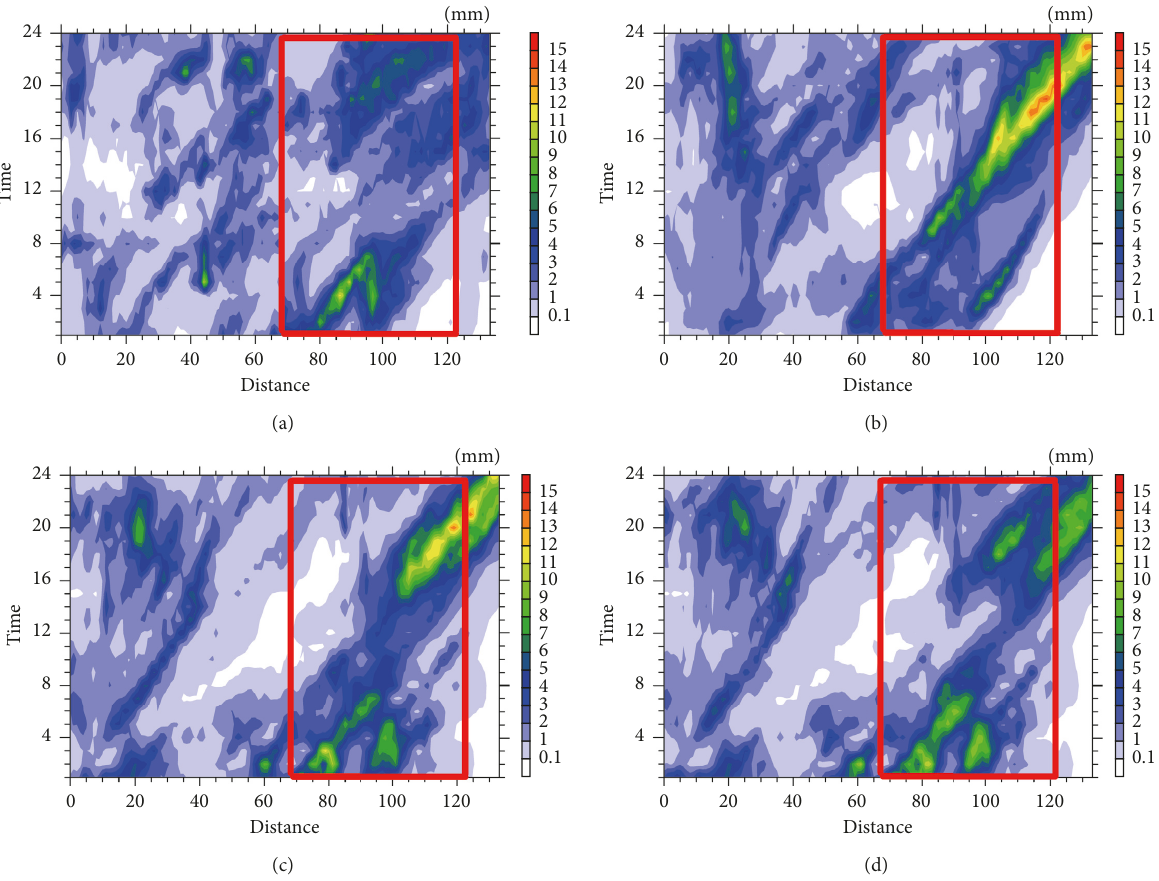
Figure 5: Time-distance cross sections along line EF direction (shown in Figure 3(a)) of hourly rainfall averaged along line FH direction (Figure 3(a)) in the rainfall belt from 0000 UTC 4 July to 0000 UTC 5 July 2014: observations (a) and simulations in (b) CON, (c) RAD, and (d) RADC (unit: mm/hr). The red solid box represents temporal evolution of rainfall over the key rainstorm area (red box in Figure 3(a)). The horizontal axis is the distance from line EF (Figure 3(a)) (unit: 10km). The vertical axis is the forecast